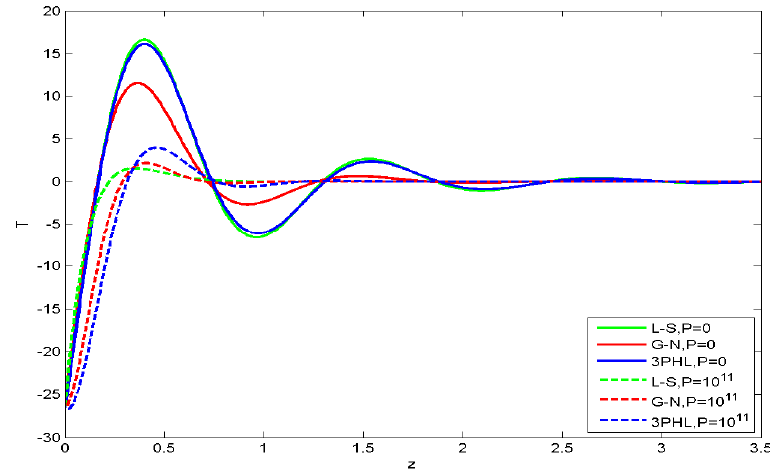
Figure 8. Total stresses τ zz + σ zz concerning z under thermoelastic theories.